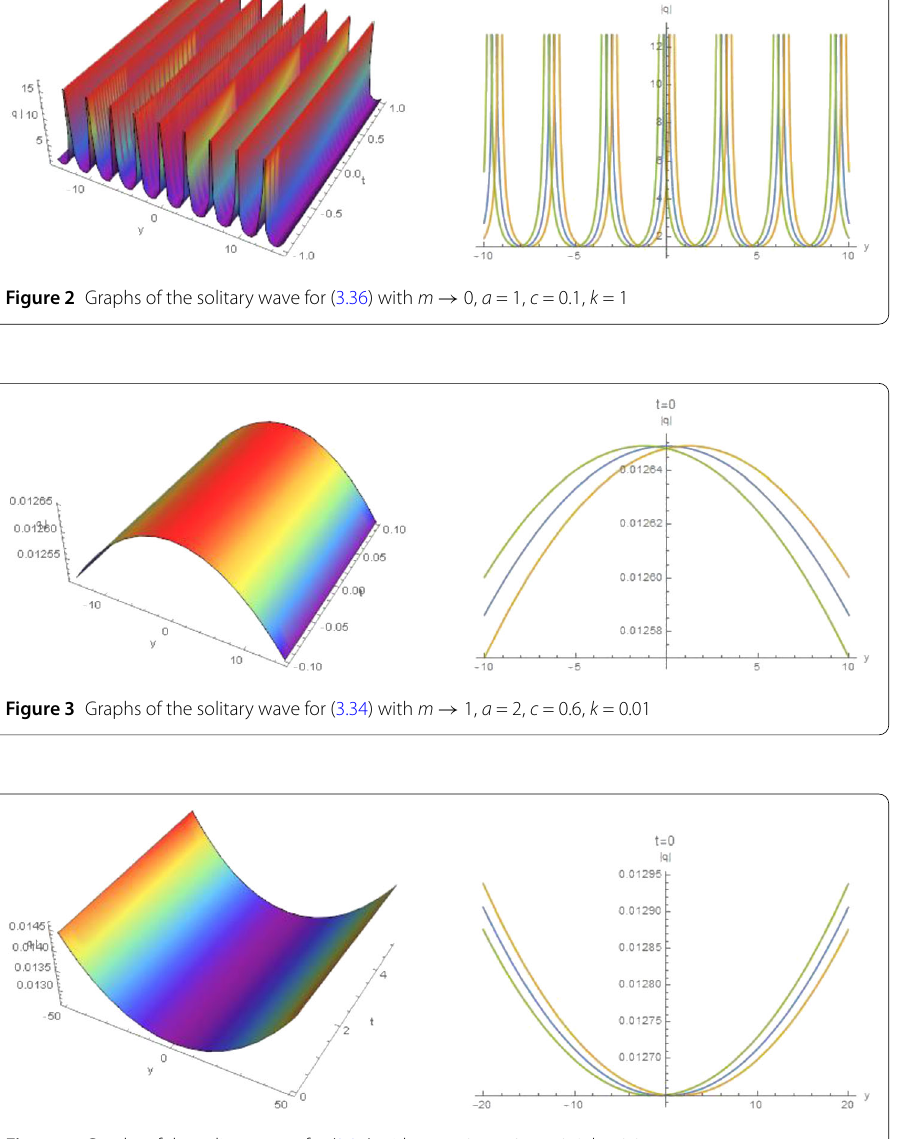
Figure 4 Graphs of the solitary wave for (3.37) with m → 0, a = 2, c = 0.6, k = 0.01